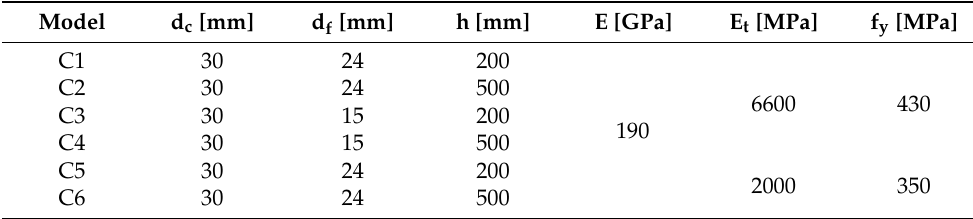
Table 3. The analyzed models of the cantilever